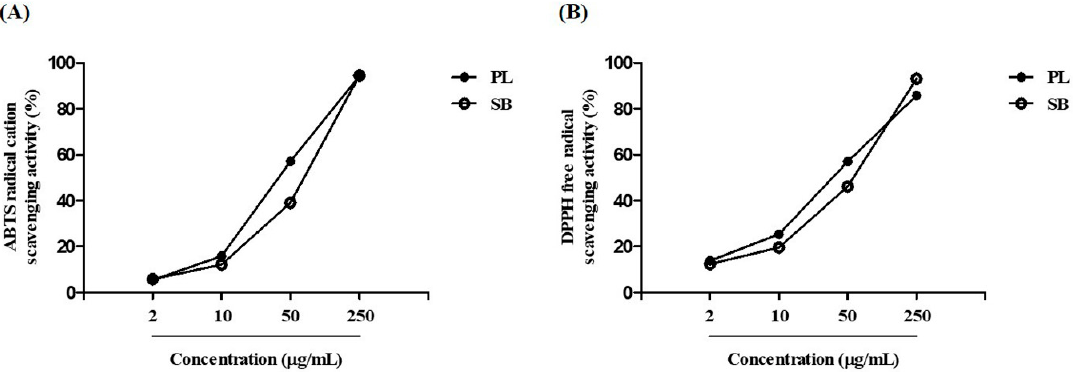
Figure 3. Radical scavenging activity of PL. ( A ) 2,2-azinobis-(3-ethyl-benzthiazolin-6-sulphonic acid) (ABTS) radical cation and ( B ) 2,2-diphenyl-2-picrylhydrazyl (DPPH) free radical scavenging activities at concentrations of 2–250 μ g/mL. SB, Scutellaria baicalensis .